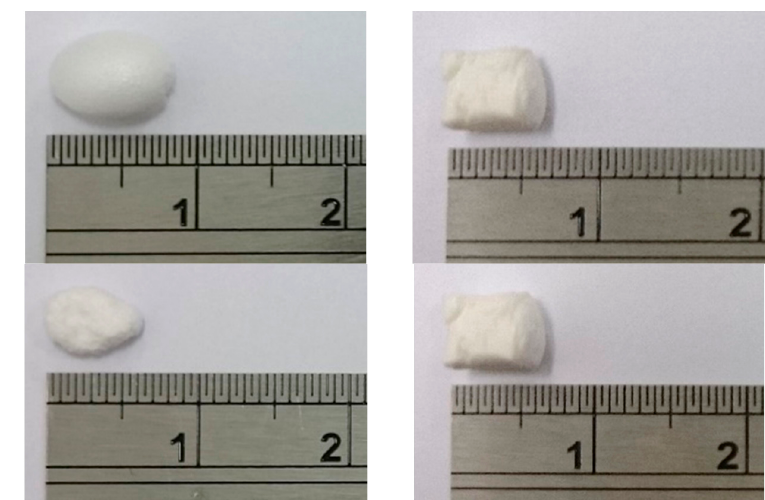
Figure 2. Comparison of surface morphology of produced foams from TPU pellet as received and compounded. and